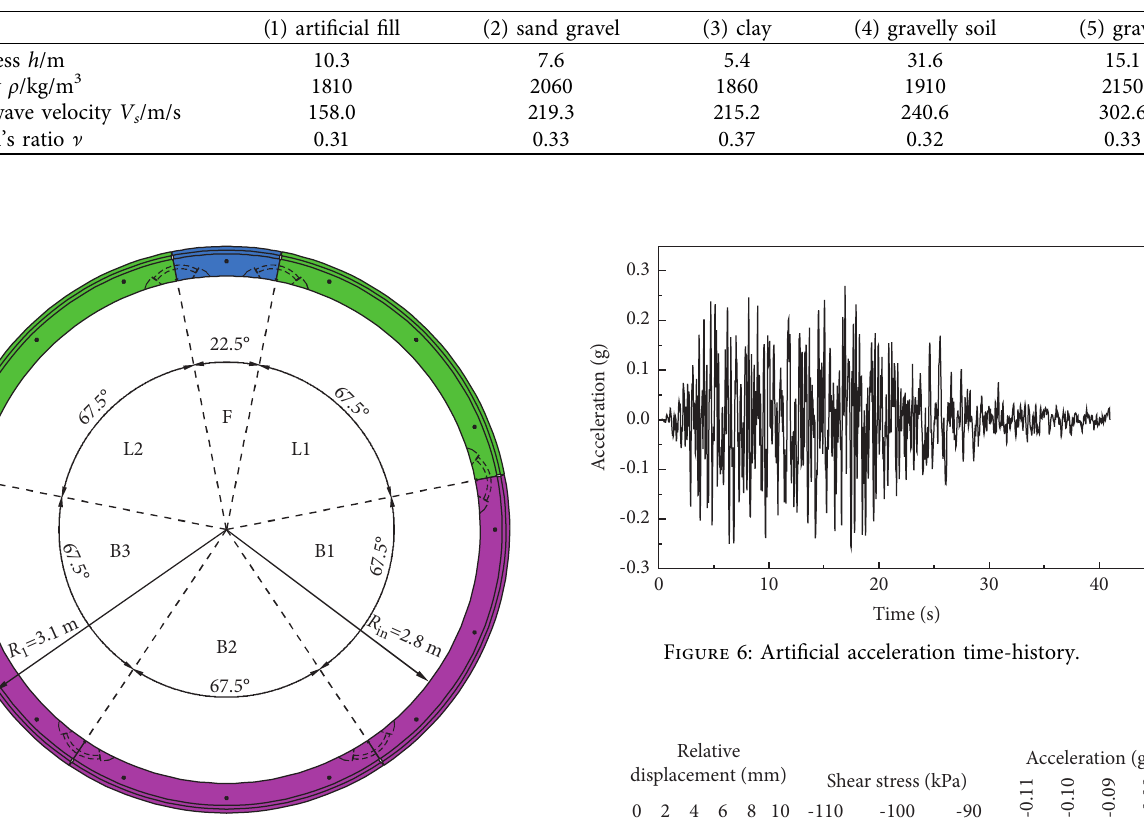
Figure 4: Layout of the segmental ring.